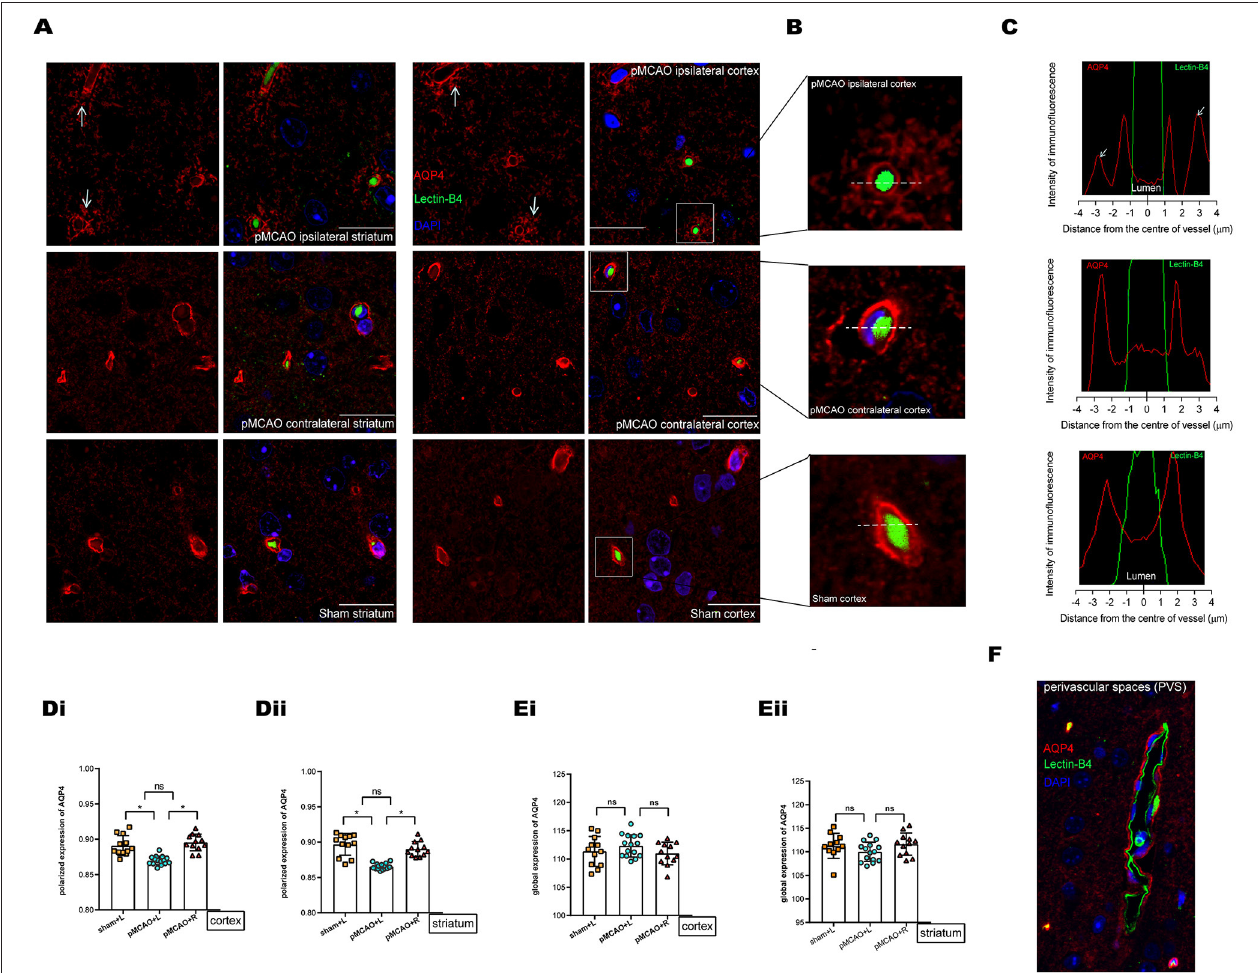
FIGURE 5 | Immunofluorescent staining of AQP4 in the cortex and striatum of sham-operated and 150min post-pMCAO animals. (A) Representative images of immunofluorescent staining of AQP4 in the cortex and striatum in 150min post-pMCAO and sham-operated animals. The scale bar is 20 µ m. Magnification is 100 × . (B) Three representative magnified images in the boxed areas of (A) are shown as a representative expression pattern. (C) The axis perpendicular to blood vessels was used to quantify the expression across vessel cross-sections. AQP4 expression surrounding blood vessels in the ipsilateral cortex of pMCAO mice was decreased (depolarization expression pattern). (D) Quantification of at least 12 images (a minimum of 3 images per animal, n = 4) shows changes in AQP4 polarization. Compared with the sham-operated and contralateral pMCAO, polarized expression of AQP4 immunofluorescence was decreased surrounding blood vessels in the cortex and striatum of the ipsilateral pMCAO brain. (E) Quantification of at least 12 images (a minimum of 3 images per animal, n = 4) shows changes in global AQP4 expression. Compared with the sham-operated and contralateral pMCAO, global expression of AQP4 immunofluorescence was not significantly altered in the cortex and striatum of the ipsilateral pMCAO brains. (F) Representative image of immunofluorescent staining of PVS (red indicates AQP4, green indicates basement membrane, and blue indicates DAPI) in the sham-operated